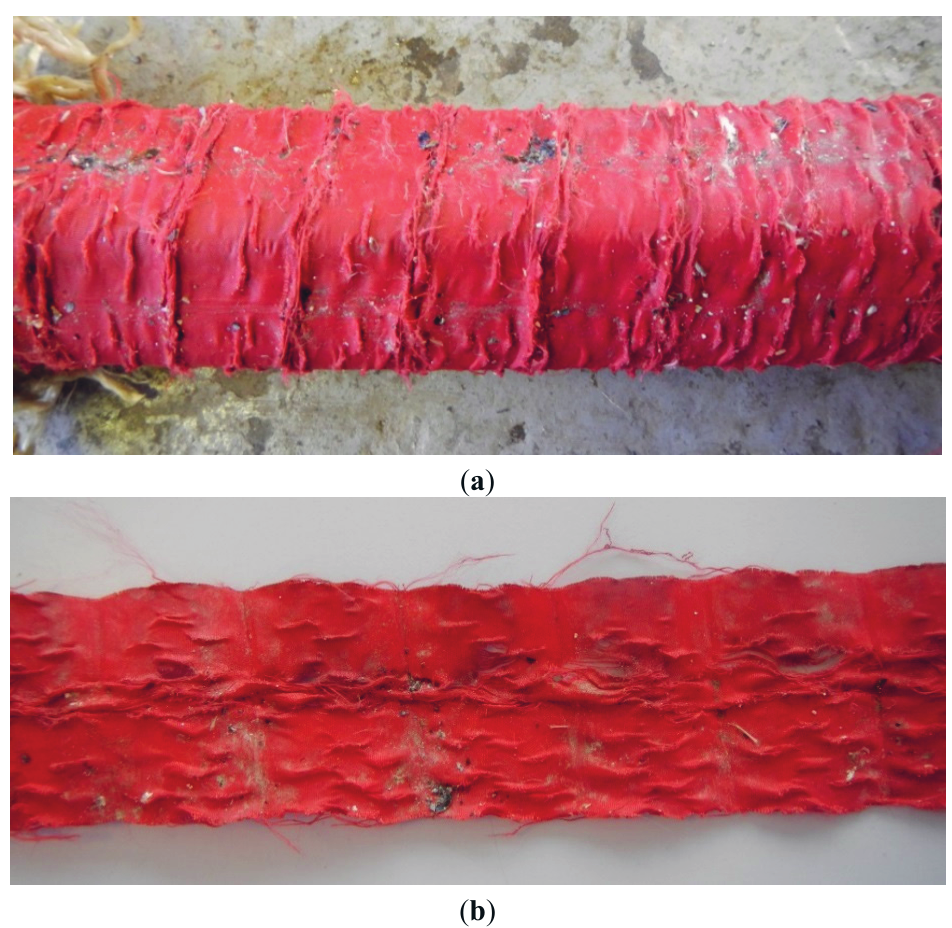
Figure 17. ( a ) Degradation of outer surface of anti-friction membrane; and ( b ) degradation of inner surface of anti-friction